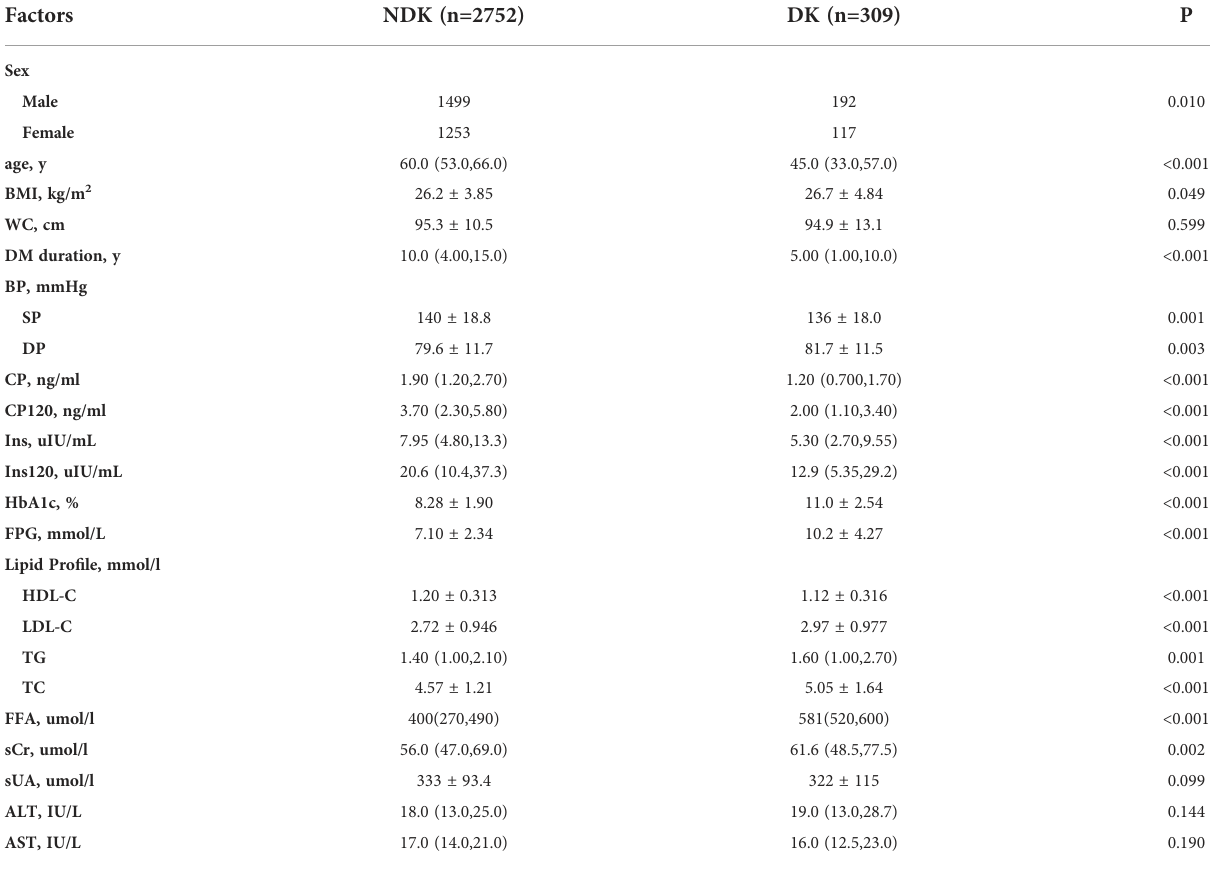
TABLE 1 Baseline characteristics of patients with and without ketosis in